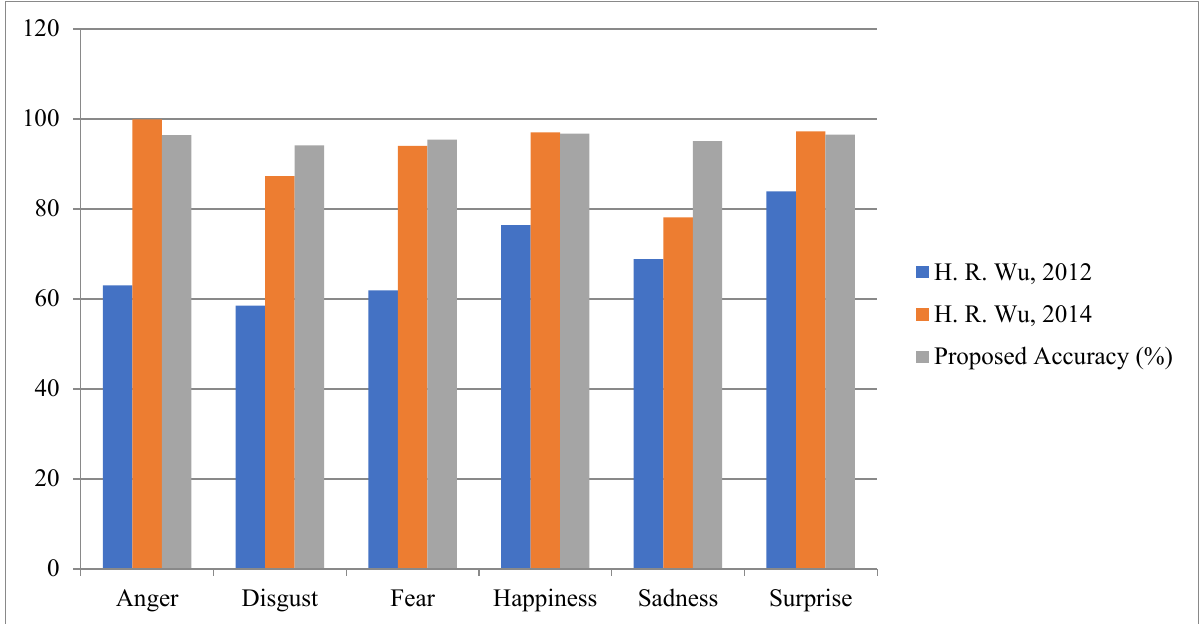
Figure 17. Accuracy Comparison for Facial Expression CK+. Table 9. Accuracy Comparison for Facial Expression JAFFE.